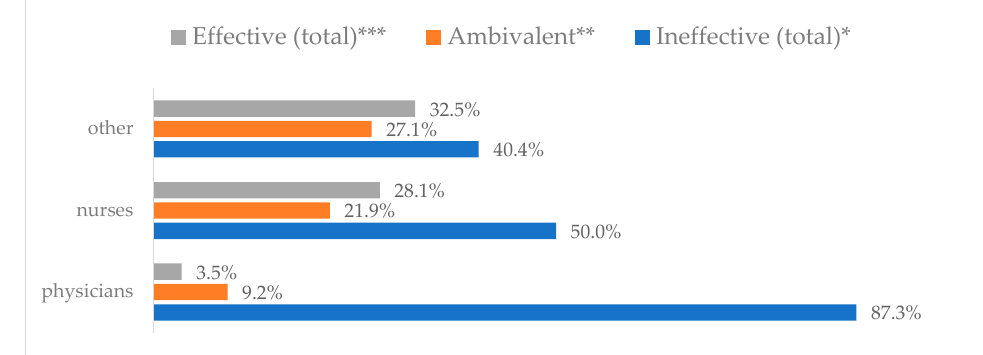
Figure 33. Taking vitamin C daily to prevent influenza virus infection by type of hospital ( N = 905). *Sum of responses: completely ineffective, ineffective, rather ineffective; **Response: neither inef- fective nor effective; ***Sum of responses: rather effective, effective, completely effective.